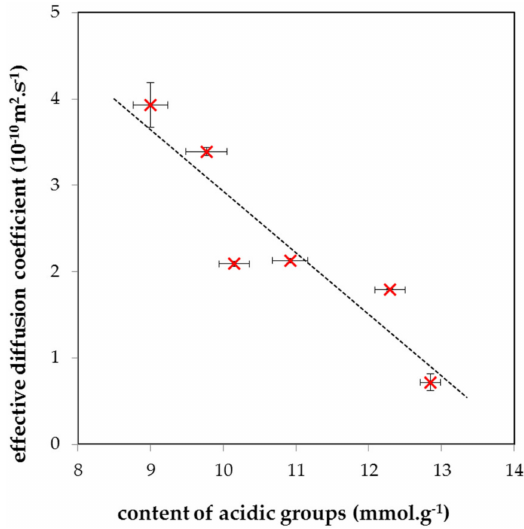
Figure 3. The dependence of effective diffusion coefficient calculated using Equation (2) on the content of acidic groups in humic acids (see β values in Table